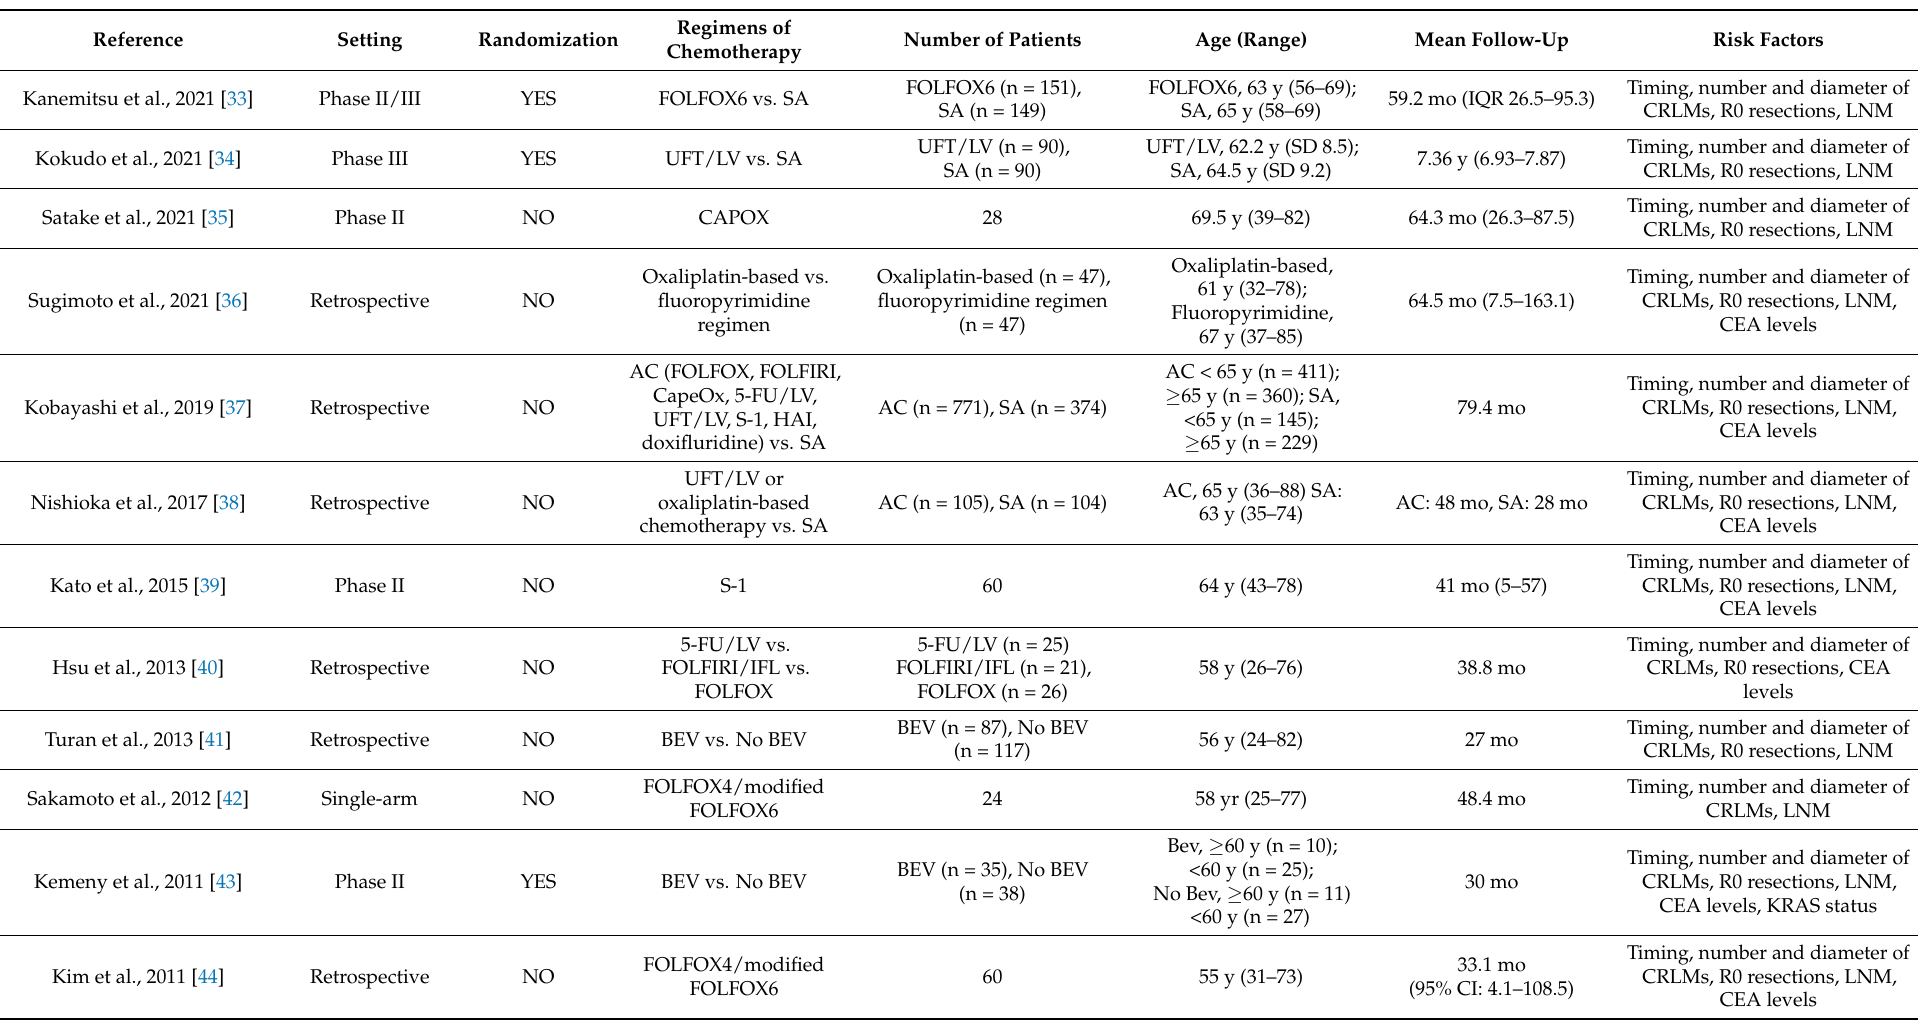
Table 1. Characteristics of patients in systemic chemotherapy